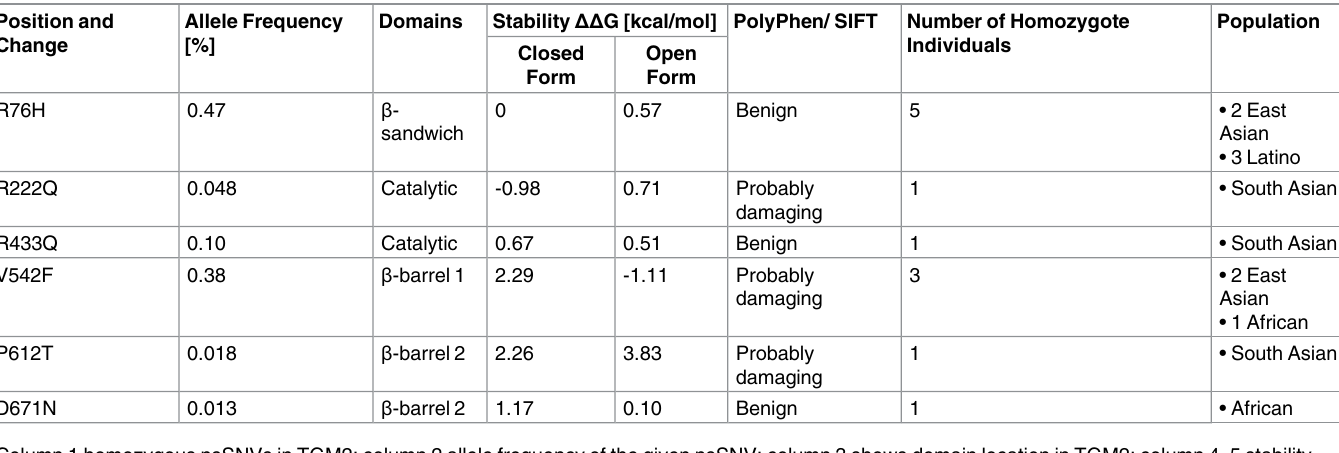
Column 1 homozygous nsSNVs in TGM2; column 2 allele frequency of the given nsSNV; column 3 shows domain location in TGM2; column 4, 5 stability values in closed and opened conformation; column 6 PolyPhen/SIFT scores; column 7 presents number of homozygote individualsfor each nsSNV and column 8 indicates population distribution of the 12 homozygote individuals. The dbSNP identifiers of the TGM2 homozygous nonsynonymous variants: